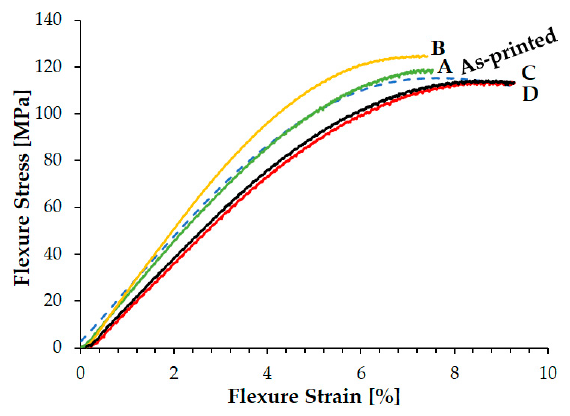
Figure 5. Stress–strain curves of samples after different ageing treatments.